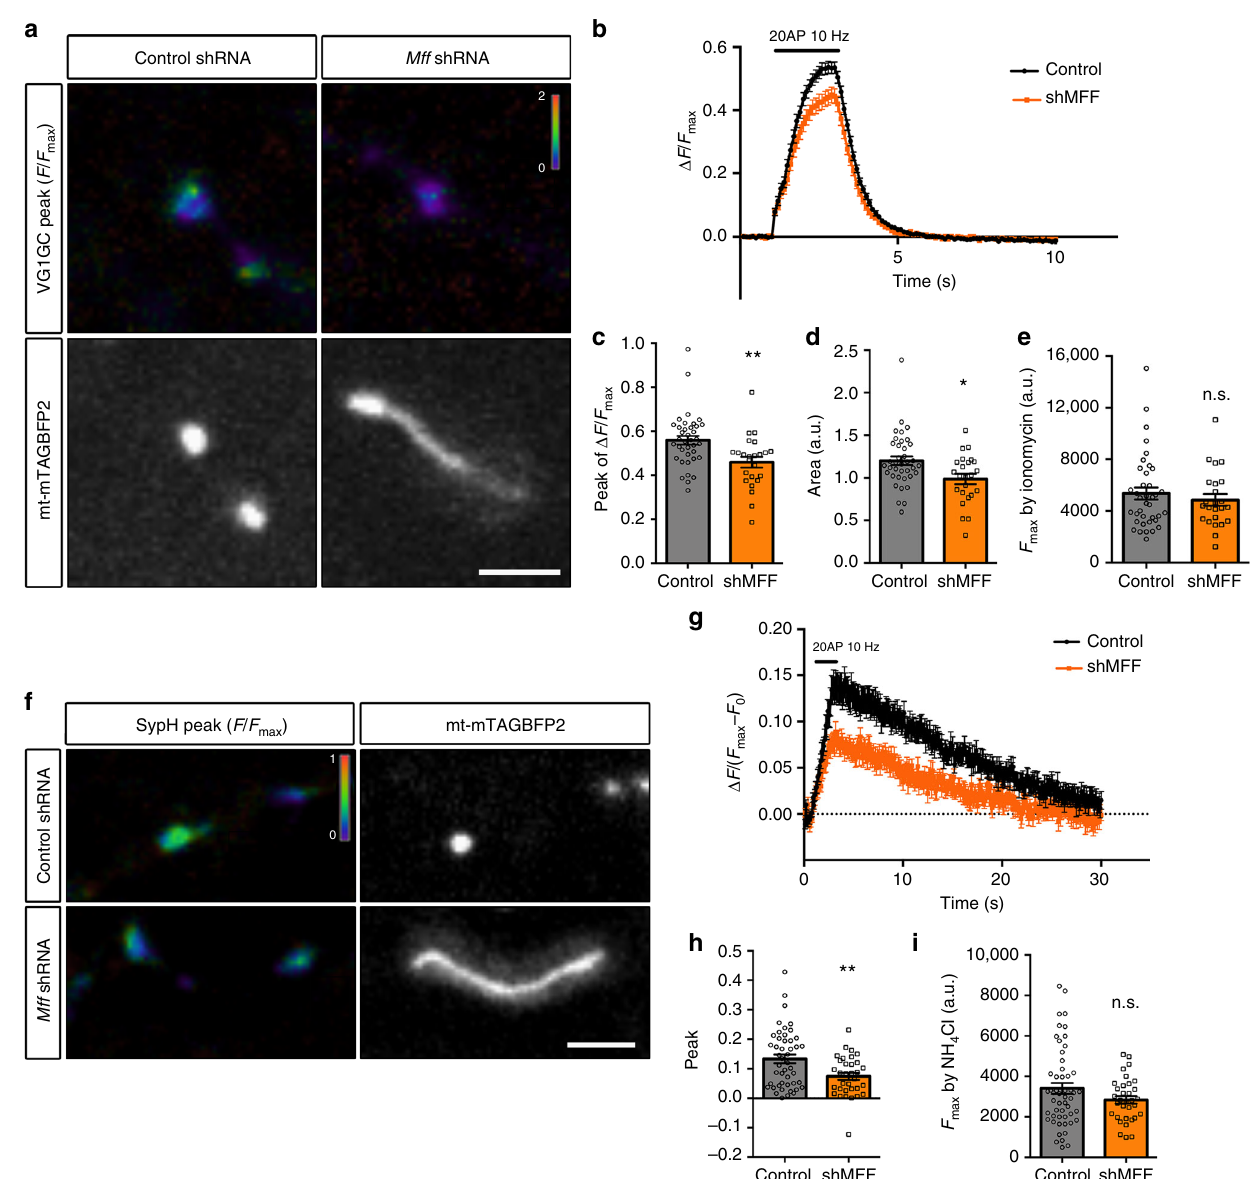
Fig. 7 Presynaptic boutons associated with long mitochondria in MFF-de fi cient axons show decreased Ca 2 + accumulation and reduced